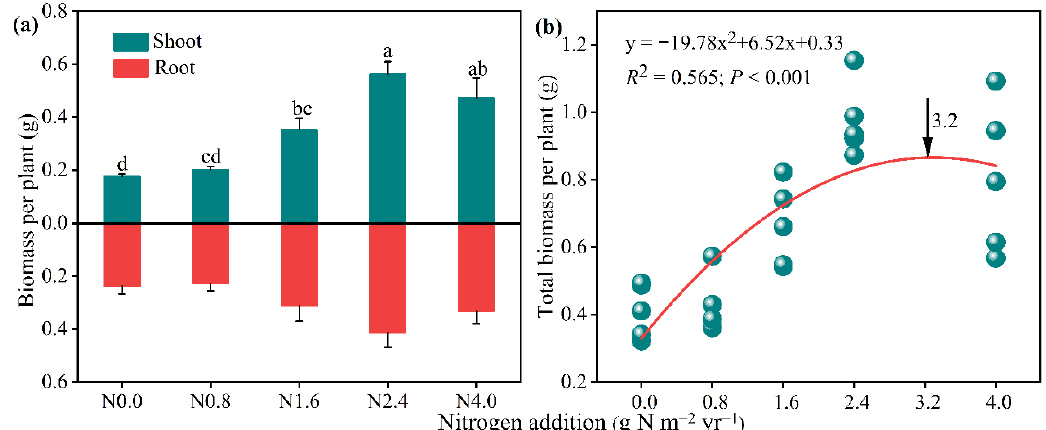
Figure 1. Biomass of A. mongolicum in response to N addition treatments and the polynomial dose- response curve of total biomass vs. N addition levels. The arrow indicates the N saturation threshold of A. mongolicum . Data are expressed as mean ± standard error ( n = 5). Different letters above the bars indicate significance differences among the N addition treatments at p < 0.05 level. Table 1. Results of one-way ANOVA for the effects of N addition on soil properties and A. mongolicum root morphological